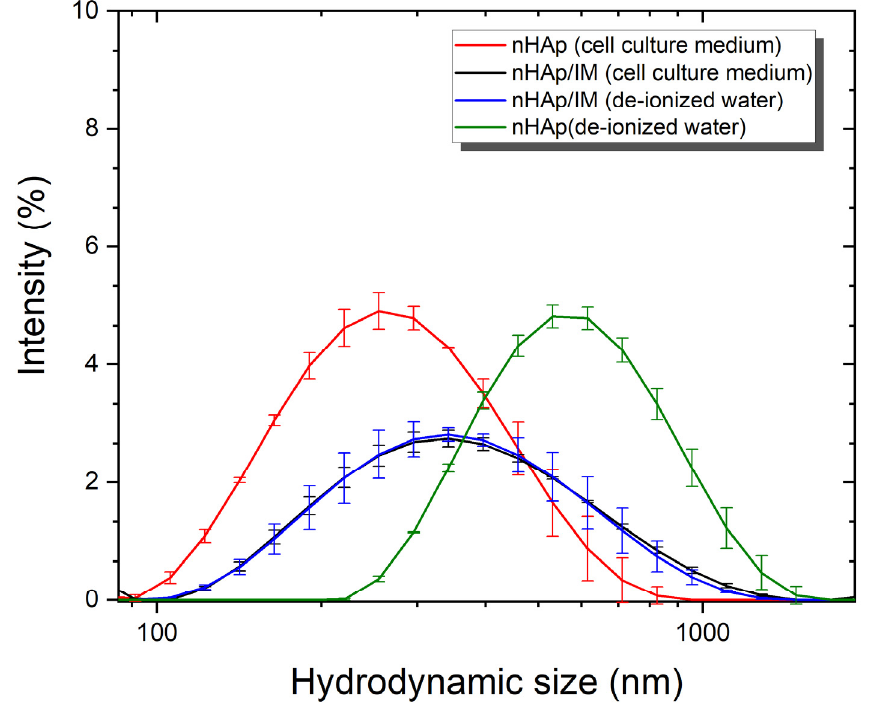
Figure 4. Hydrodynamic size of nanohydroxyapatite (nHAp) and nHAp modified by imatinib (nHAp / IM) monitored in de-ionized water and cell culture medium.